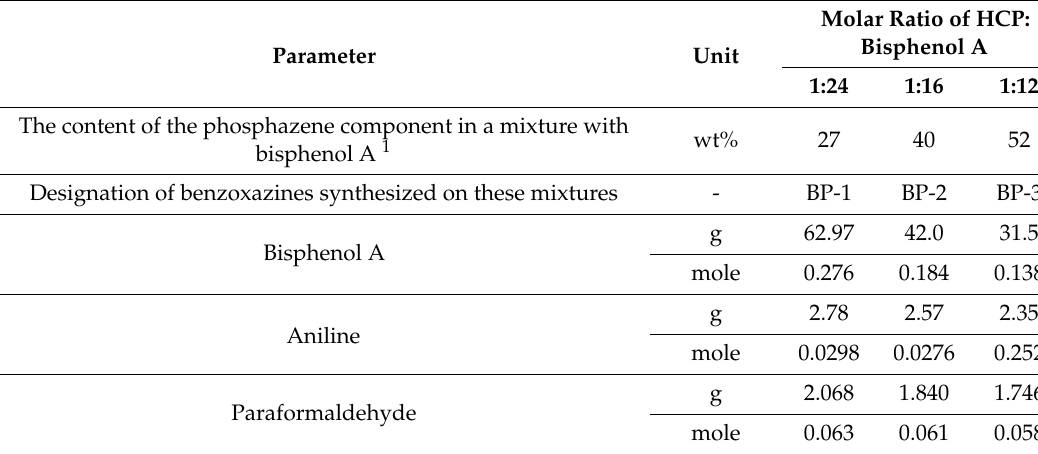
Table 1. The amount of starting reagents for the synthesis of hydroxyaryloxycyclotriphosphazene with a di ff erent ratio of HCP: bisphenol